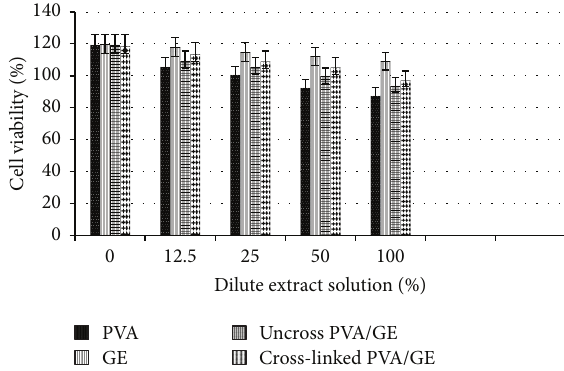
Figure 2: Cell viability of PVA, GE, uncross PVA/GE, and cross- linked PVA/GE IPN blend. The MTT assay was used to measure the viability of L929 cells at various dilute extract solution concentra- tions. Media at 100% were used as a control. Standard errors were expressed as bar diagram.